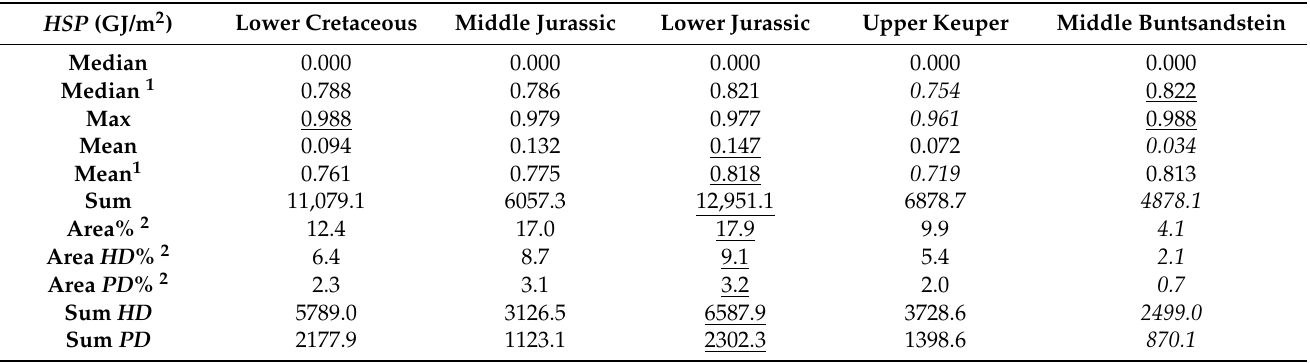
Table 4. Statistical HSP values of the reservoirs. 1 = Excluding areas of no potential, 2 = percent of total area with potential greater than 0. Underlined values represent maximum and italics represent the minimum value of investigated units for the respective